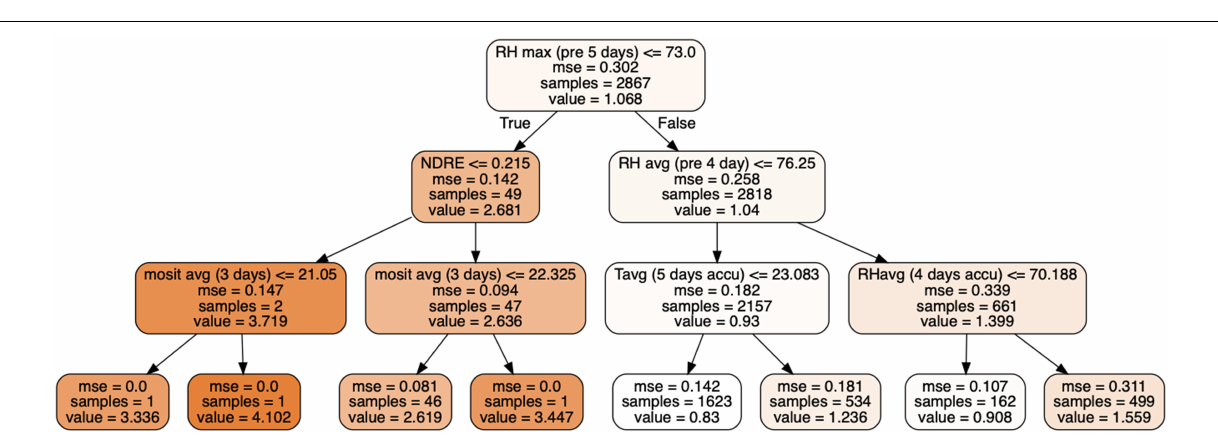
FIGURE 4 | A decision tree with three depths. The nodes with dark colors have a higher estimated clipping